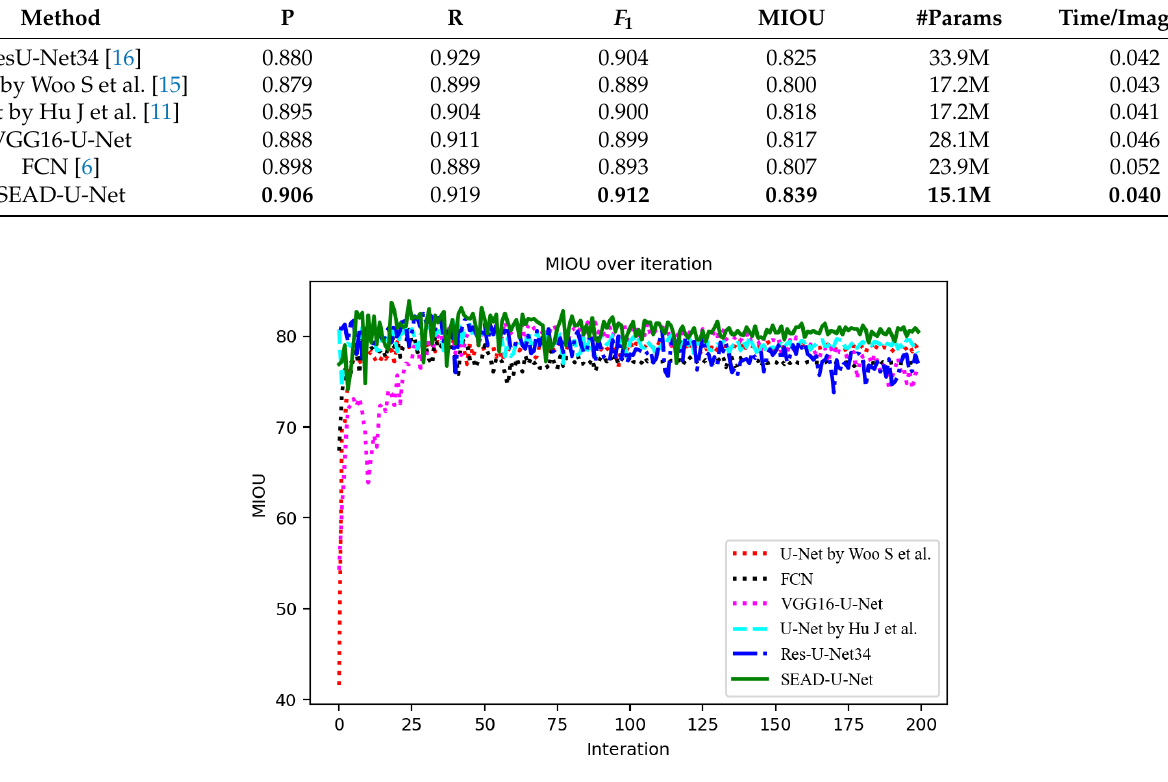
Figure 6. The MIOU comparison of the different methods.